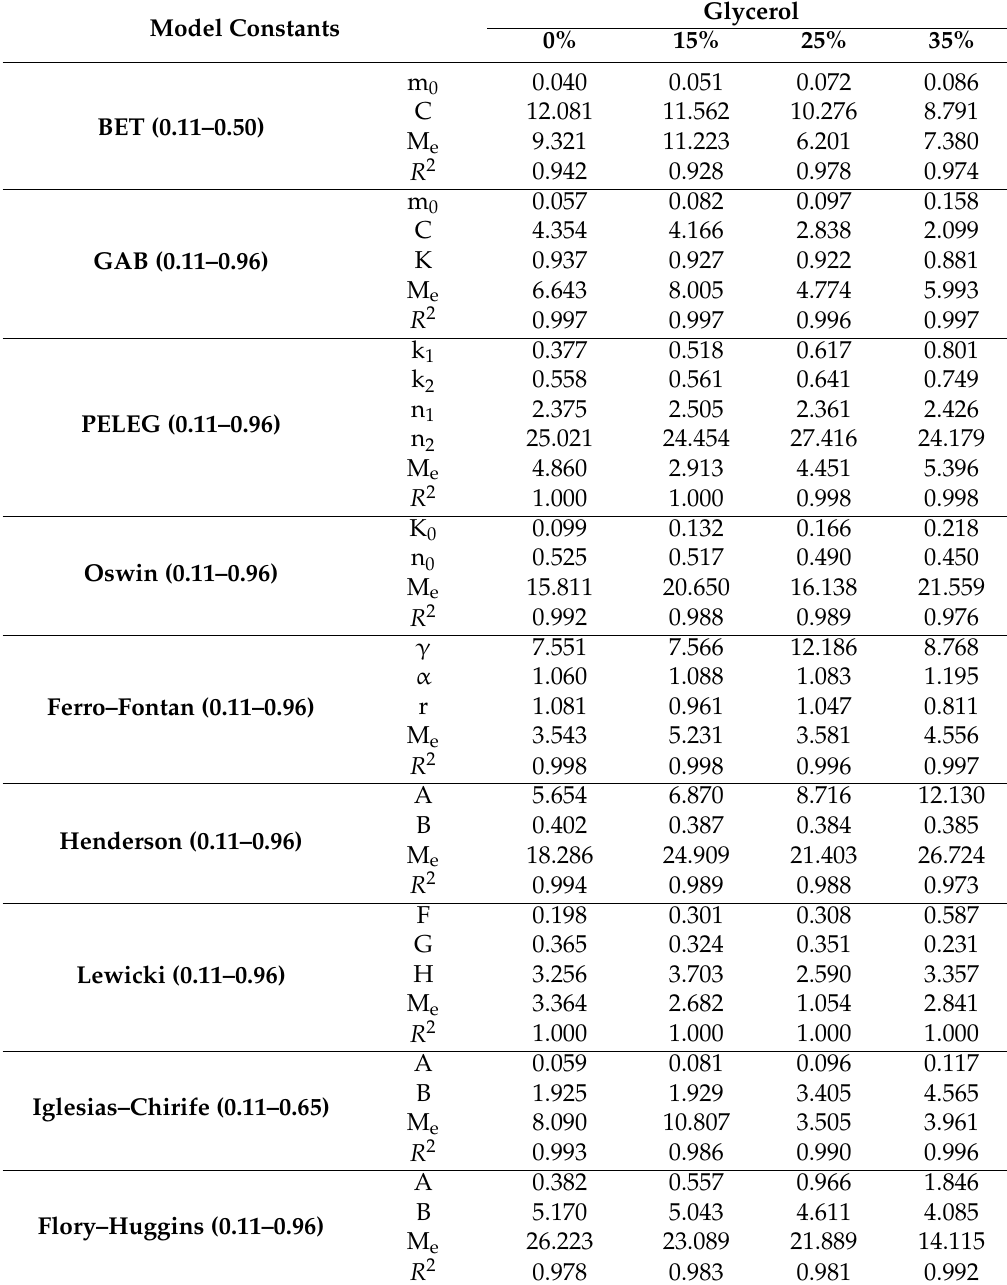
Table 4. Estimated model constants and values of coefficients and mean relative percentage deviation moduli for different pea starch films at 25 ˝